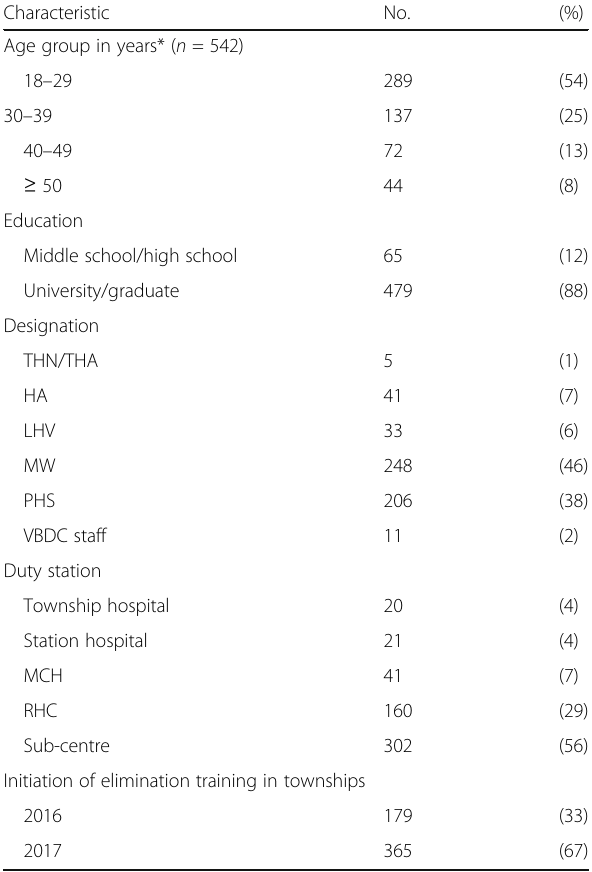
Table 1 Background characteristics of BHS and VBDC teams at six targeted townships for malaria elimination, Myanmar, 2017 to 2018 ( n =